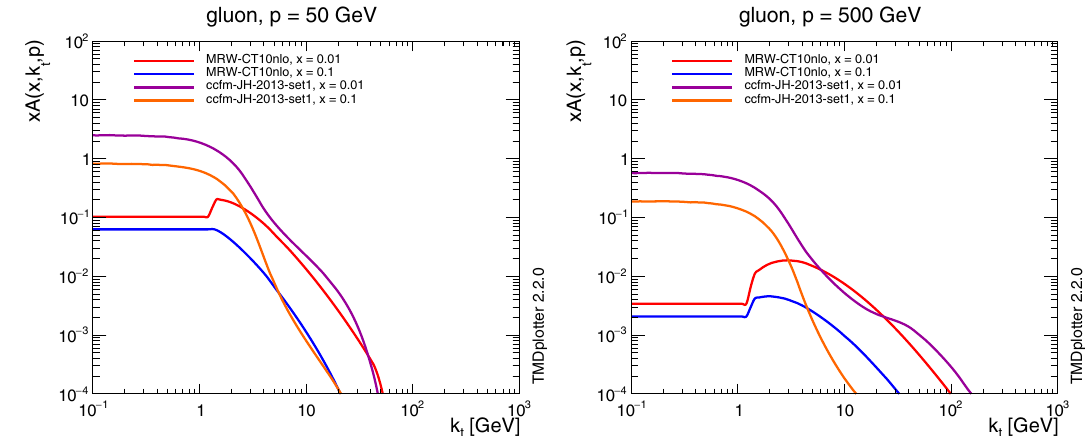
Fig. 3 Transverse momentum distribution of the TMD gluon density at a scale μ = 50 GeV (left) and μ = 500 GeV (right) obtained with the MRW approach and the CCFM evolution of Ref. [39]